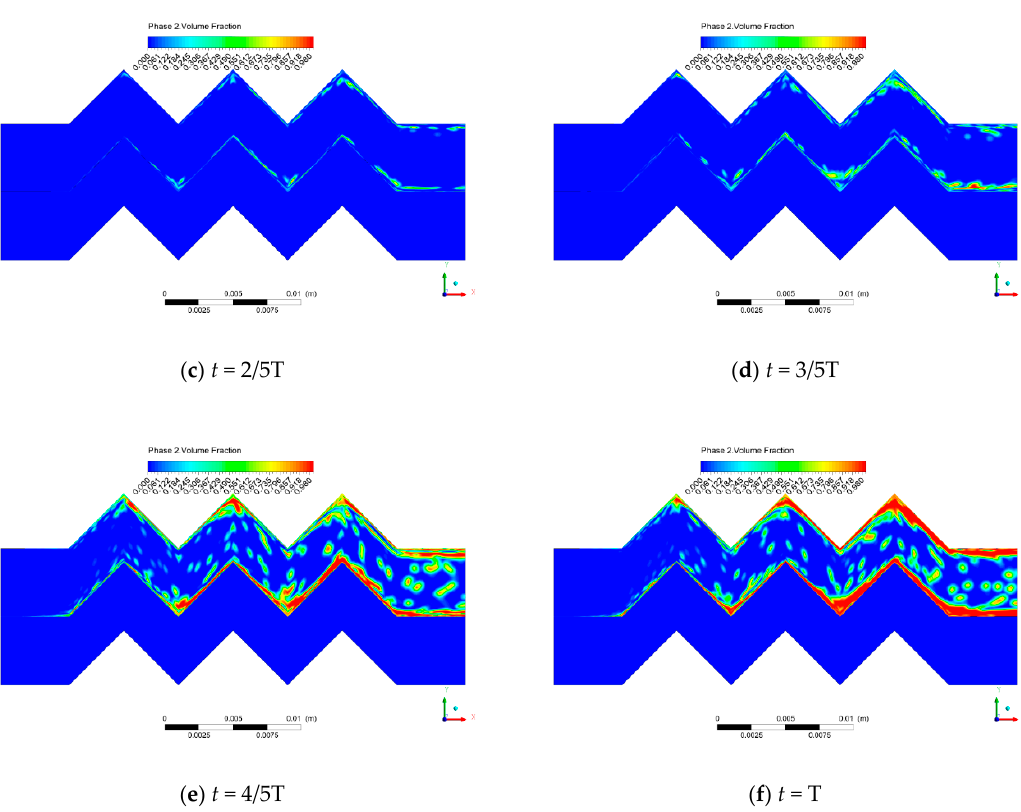
Figure 6. Gas phase volume fraction distribution at different time.